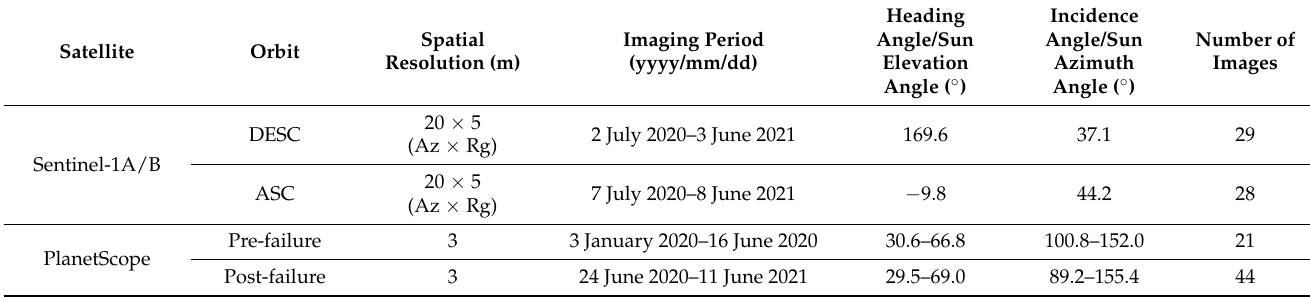
Table 1. Basic parameter of satellite remote sensing